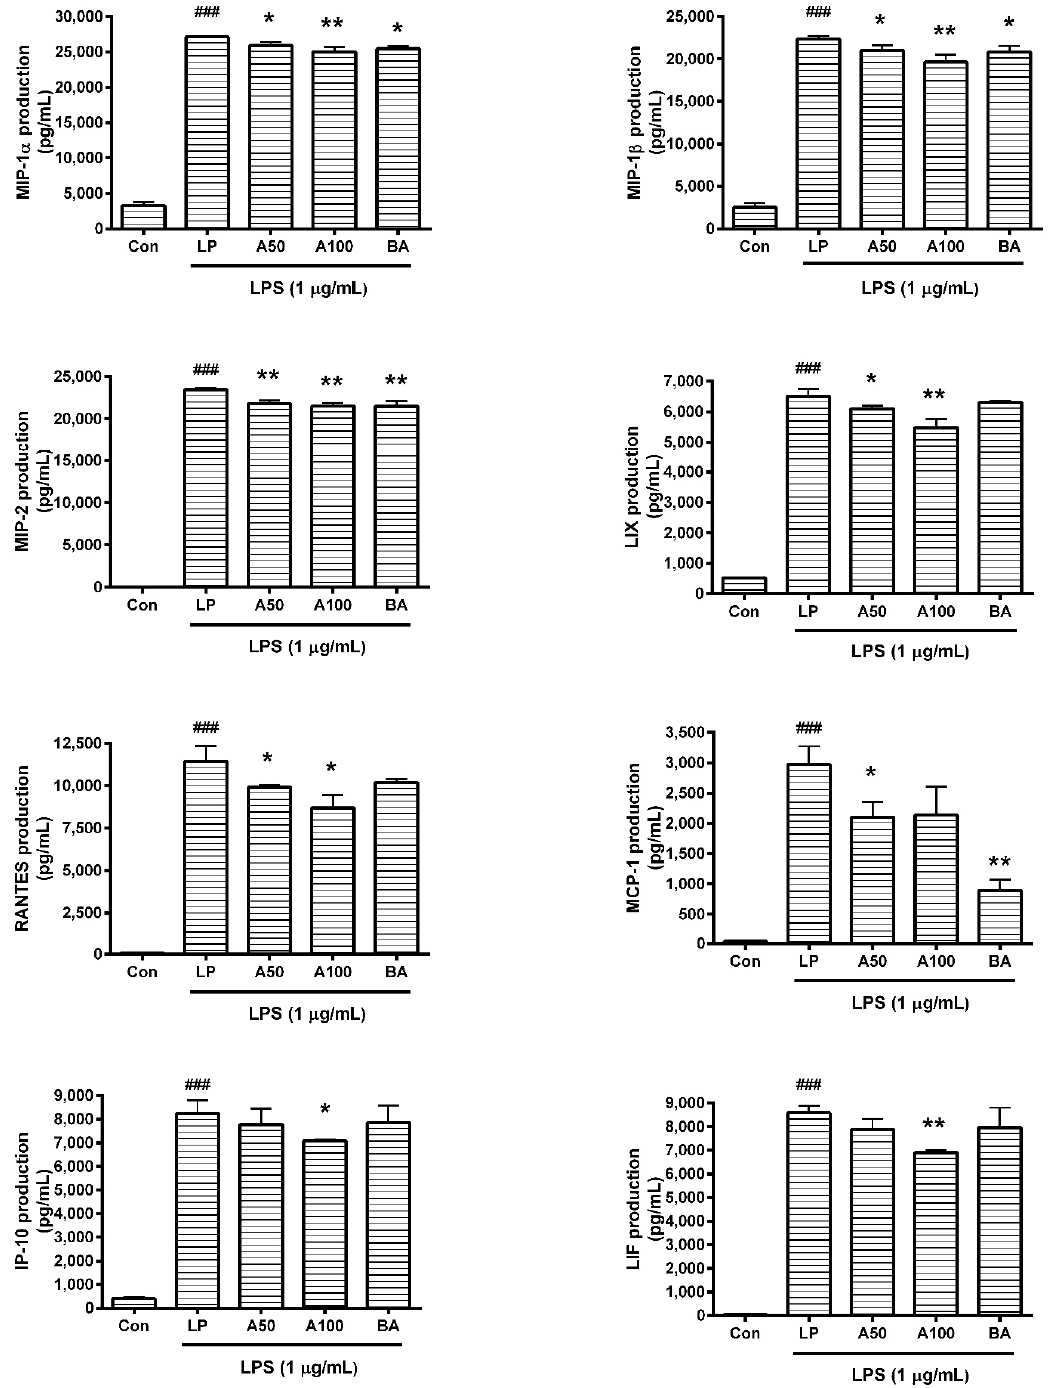
Figure 3. Effects of Angelica sinensis root water extract (ASW) on macrophage inflammatory protein (MIP)-1 α , MIP-1 β , MIP-2, lipopolysaccharide-induced CXC chemokine (LIX), regulated on activation, normal T cell expressed and secreted (RANTES), monocyte chemotactic activating factor (MCP)-1, interferon gamma-induced protein 10 (IP-10), and leukemia inhibitory factor (LIF) production in lipopolysaccharide (LPS)-induced RAW 264.7. Cells were treated for 24 h. Con means the group treated with media only. LP means the group treated with 1 µ g/mL of LPS alone. A50 and A100 mean 50 and 100 µ g/mL of ASW respectively. BA means baicalein (100 µ M). Values are the mean ± standard deviation of at least three independent experiments. Statistical significance was calculated by one-way ANOVA and a Tukey multiple comparison test. ### p < 0.001 vs. Con; * p < 0.05 vs. LP; ** p < 0.01 vs.